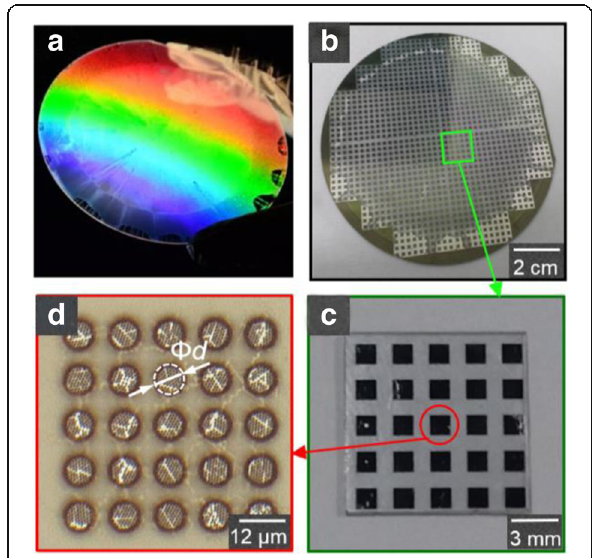
Fig. 3 a Diffraction image of the fabricated 4-in. wafer-level monolayer nanosphere mask. Photographs of the fabricated microlenses and their arrays on a glass substrate in ( b ) the wafer level and ( c ) the chip level. d Optical microscope image of the 8- μ m microlens and its